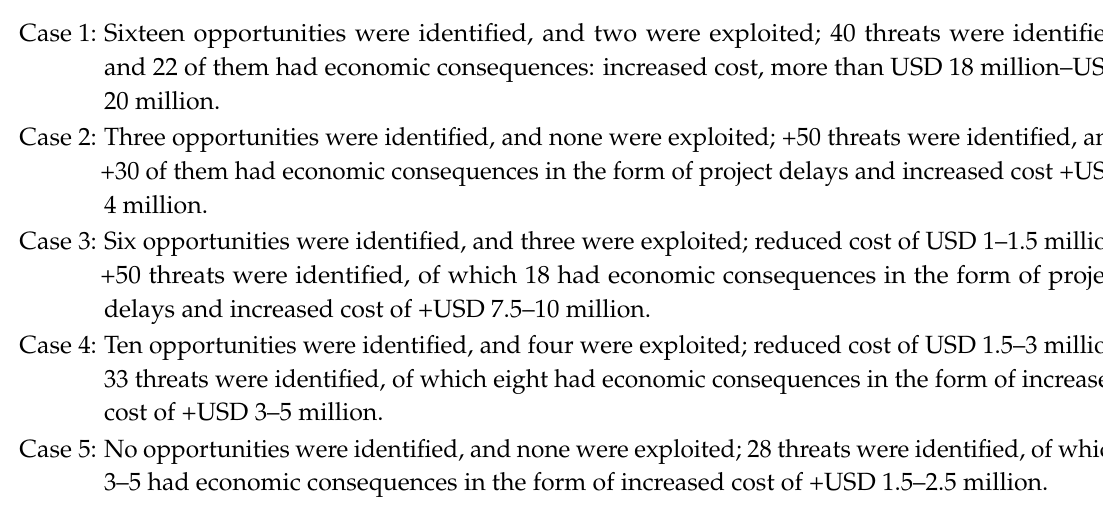
Table 1 lists data for each project phase: Phase I “concept development”, Phase II “design”